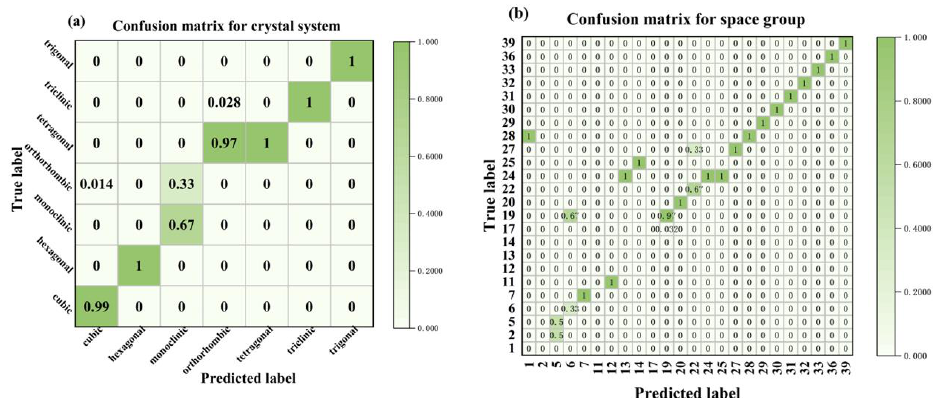
Figure 3. Confusion matrix for RF-identified crystal systems and space groups: ( a ) crystal system; ( b ) space.